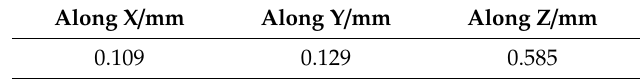
Table 4. Maximum error between calculated results based on PSDs and laser displacement sensor.